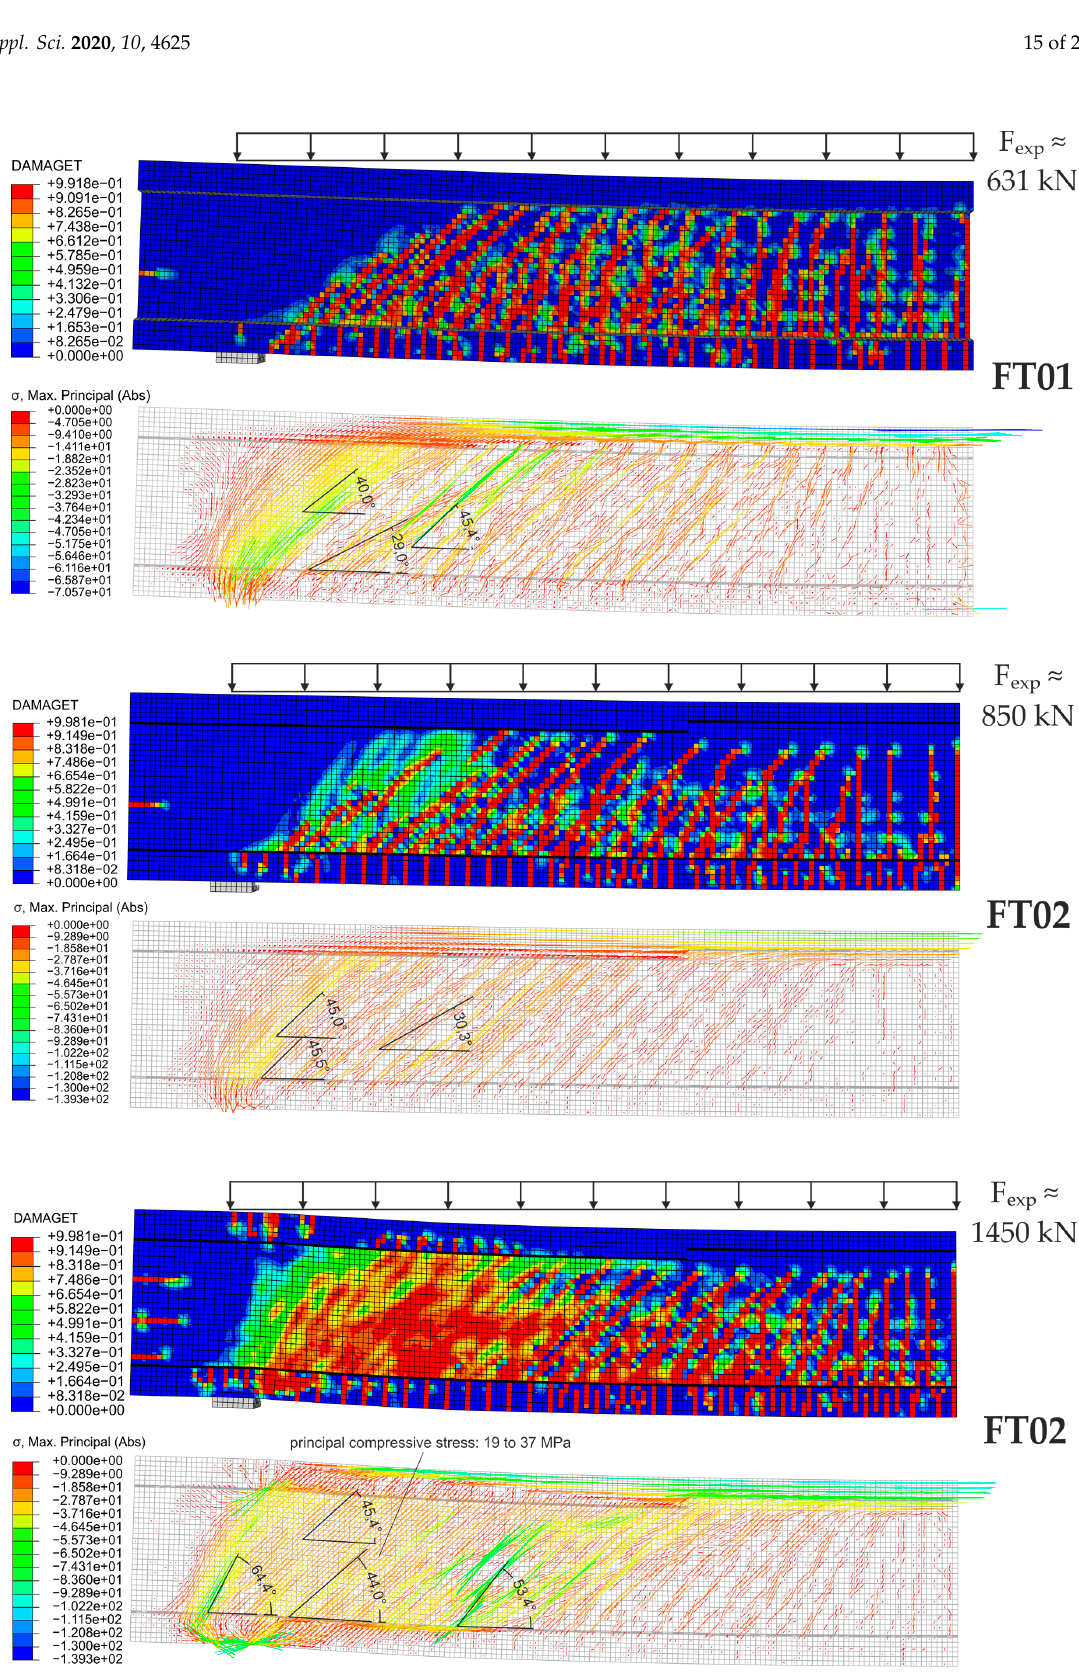
Figure 14. Results from FE-calculation: DamageT and principal compressive stress trajectories for FT01 and FT02.